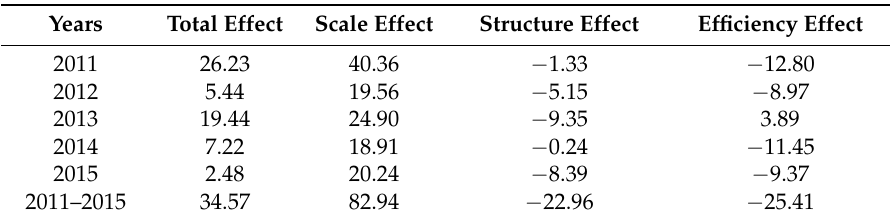
Table 5. Decomposition results of electricity consumption